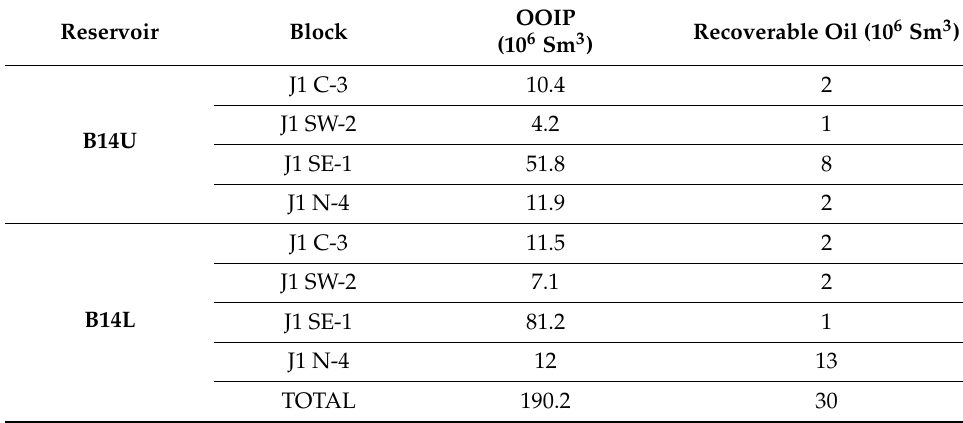
Figure 5. The distribution of porosity and permeability of different rock types in the reservoir. Table 6. Recoverable volumes in the B14U and B14L